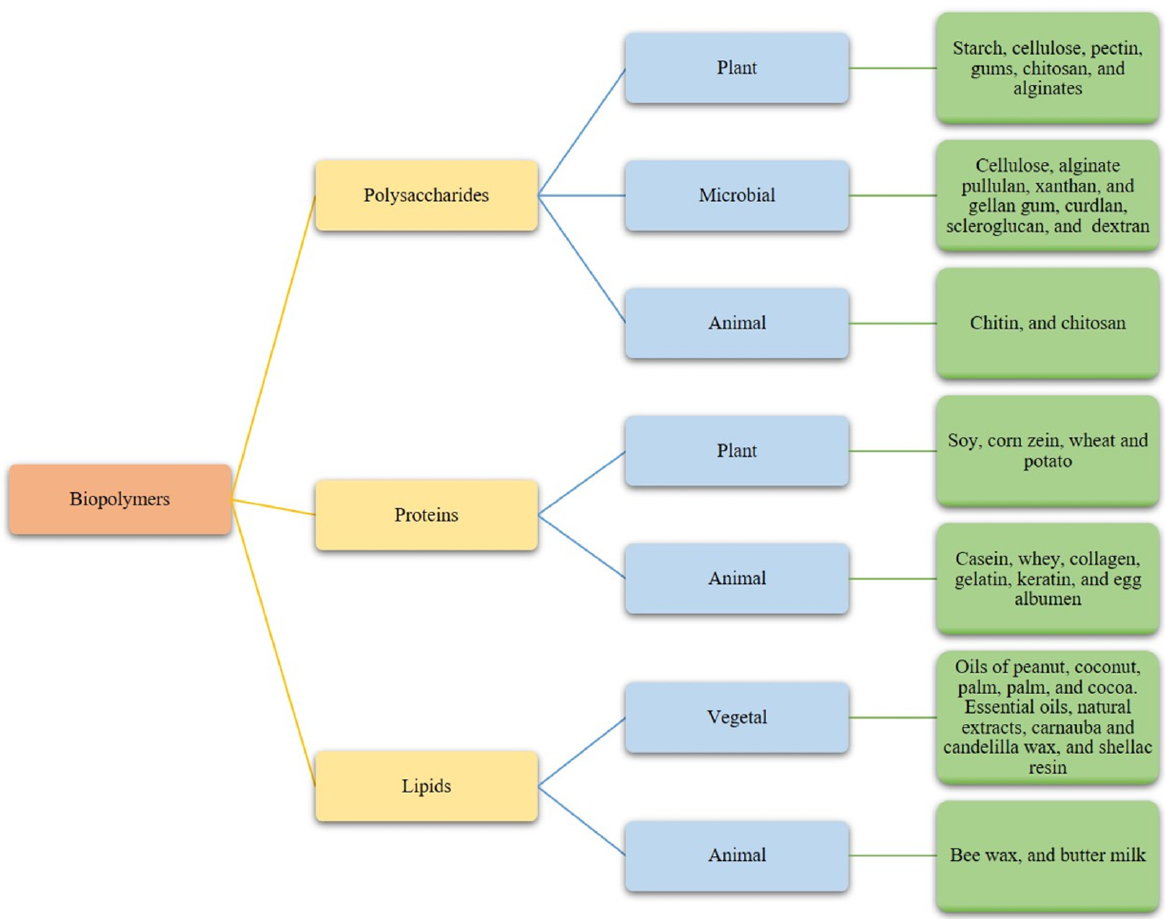
Figure 1. Biopolymers used as natural edible films and coatings and their sources.